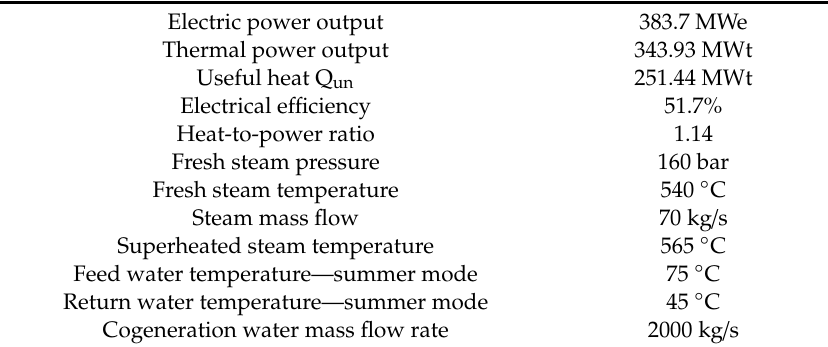
Table 2. The main parameters of the cooling, heating and power (CHP)